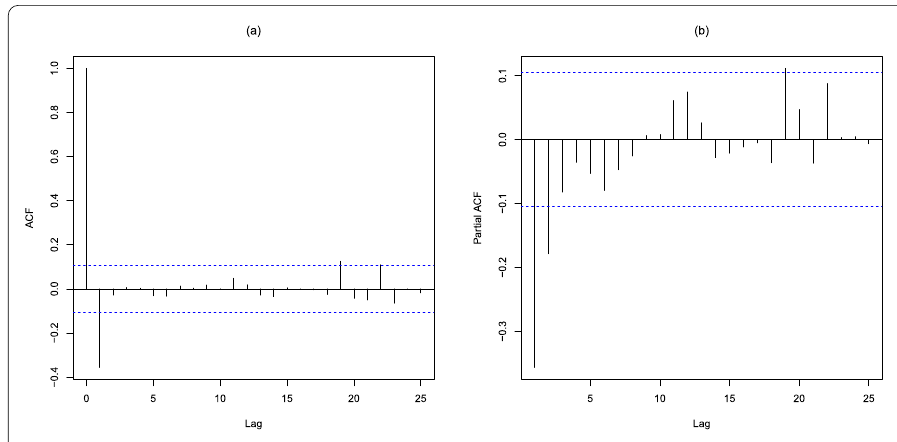
Figure 4 Autocorrelation function and partial autocorrelation function of time series of returns